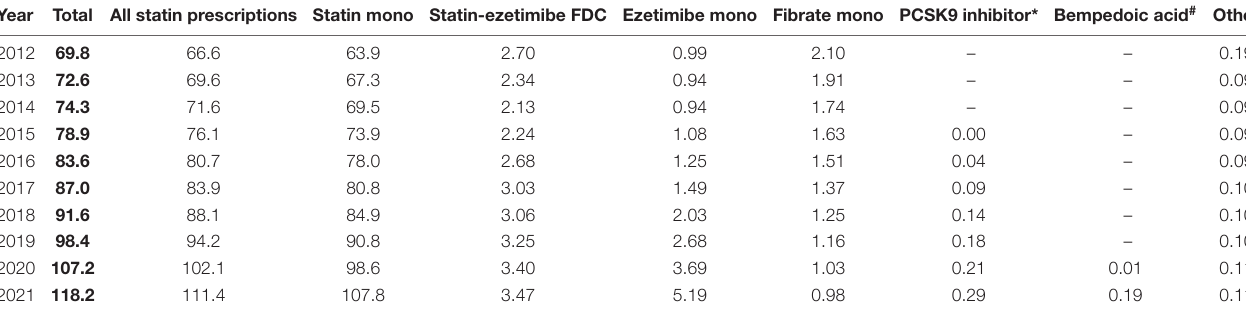
TABLE 1 | Prescription of lipid-lowering agents 2012–2021 (in